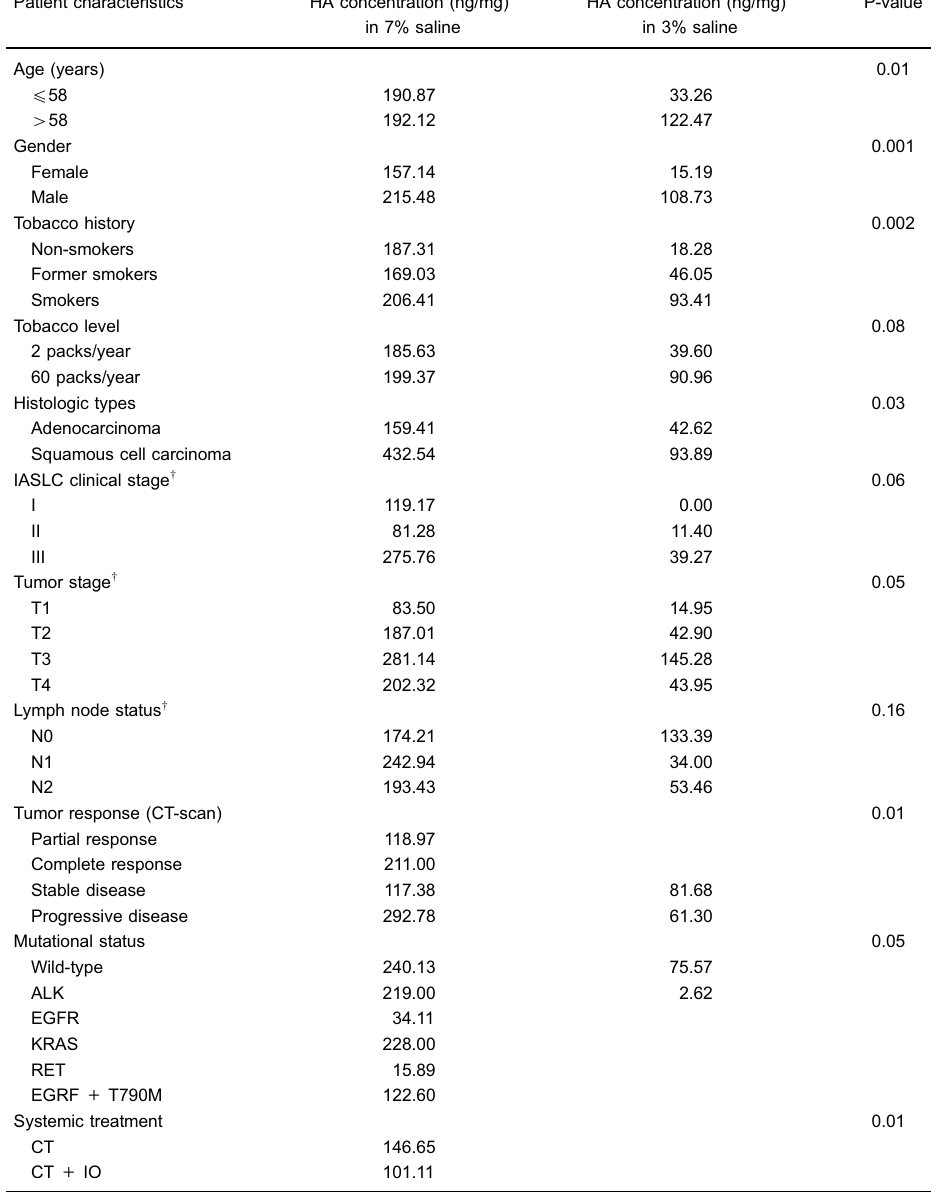
Table 1. Clinicopathological characteristics of the cancer patients strati fi ed according to sputum hyaluronic acid (HA) level. Patient